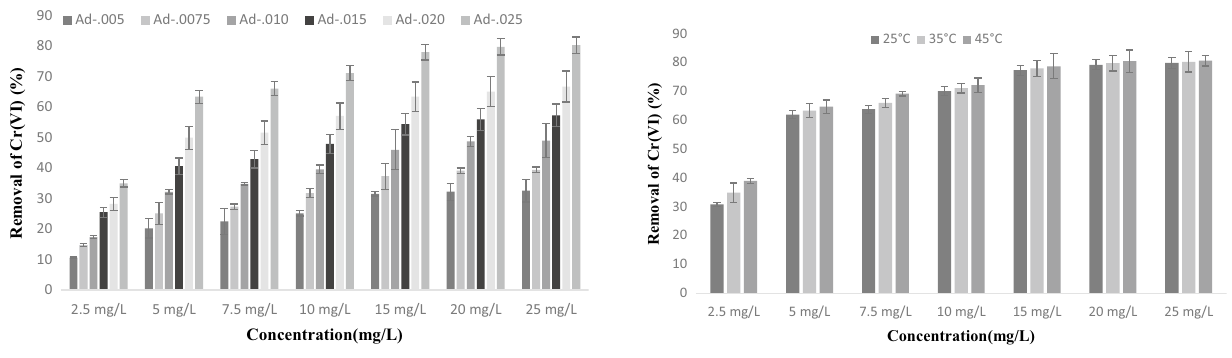
Fig. 7 Combined effect of initial concentration and temperature on chromium